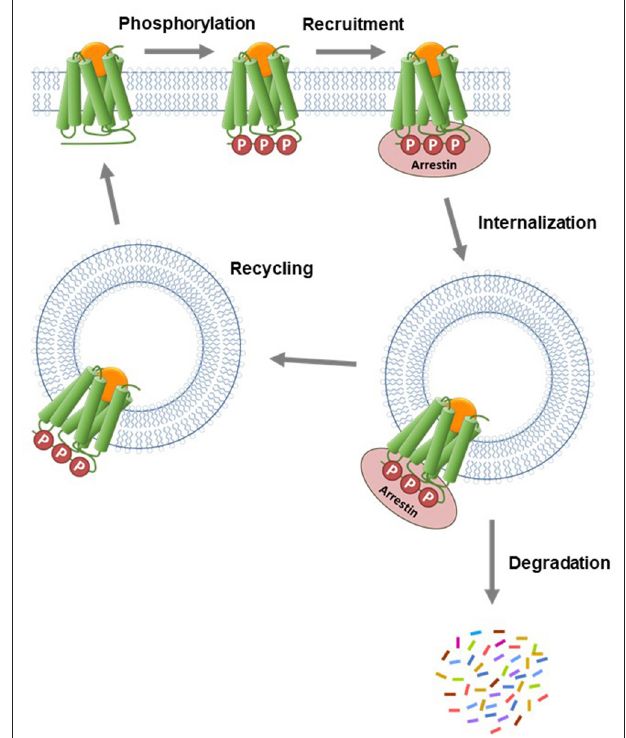
FIGURE 7 | Canonical mechanism of arrestin recruitment and subsequent regulation of signaling events. The agonist-activated GPCR is phosphorylated by kinase enzymes on intracellular regions. The phosphorylated GPCR then recruits arrestin. This step blocks G-protein interaction and subsequent signaling and is the canonical mechanism of receptor desensitization. The receptor-arrestin complex is then internalized into endosomes via clathrin-coated pits. Following internalization, the receptor is trafficked via two primary pathways. Either the receptor is transported to lysosomes where it is degraded or it is recycled to the plasma membrane where it can contribute again to G-protein